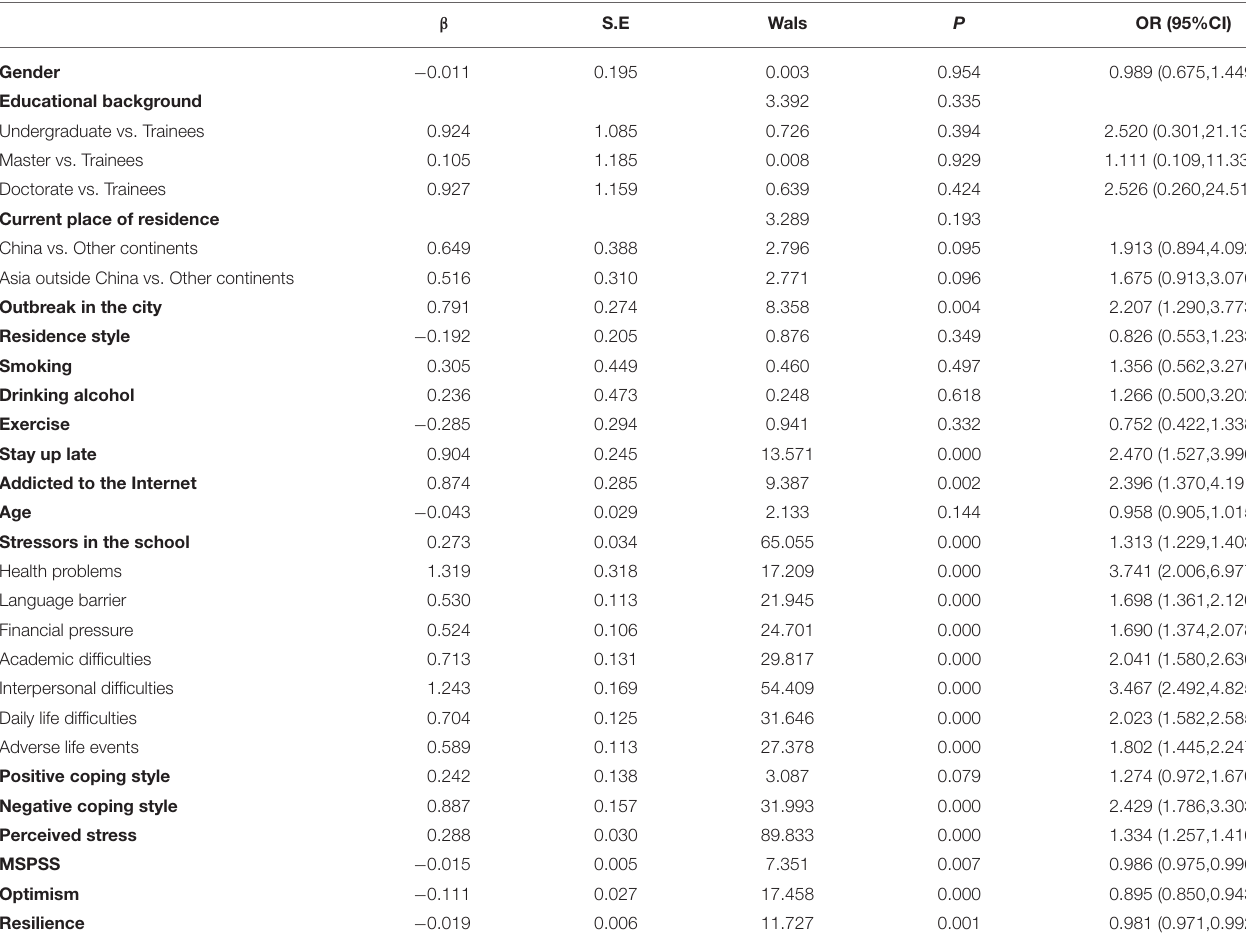
TABLE 2 | Univariate logistic regression analysis on results of anxiety symptoms ( n =